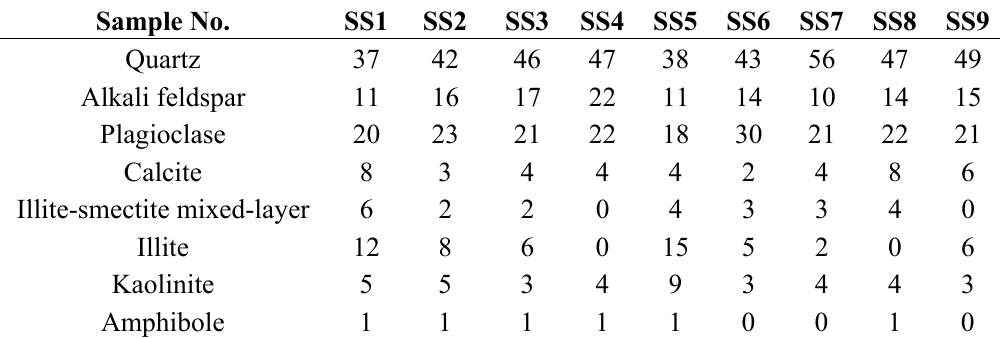
Table 1. Mineralogy of suspended solids.